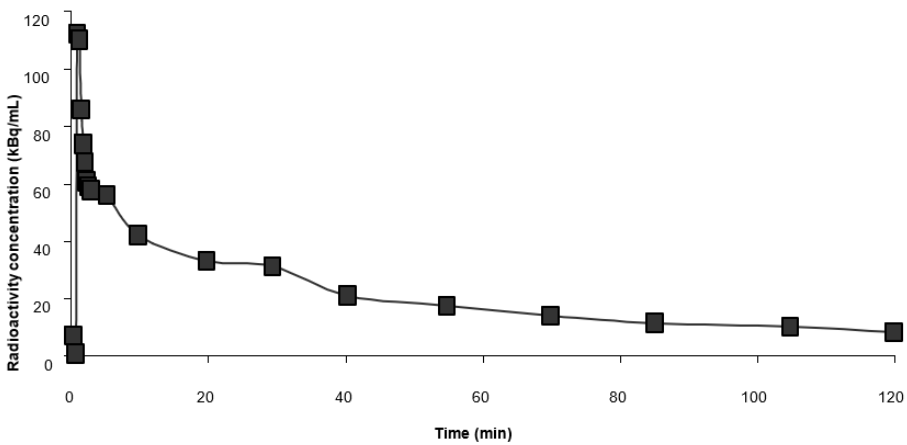
Figure 2. Representative plasma time-activity curve of the study from one of the raccoon dogs.